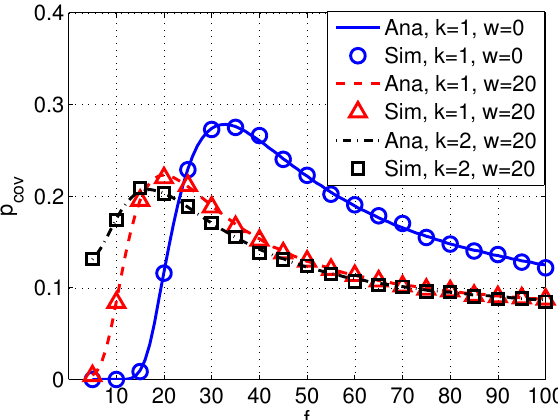
Figure 8. Coverage p cov versus frequency f with different spreading factor k and wind speed w . System parameters are set as R d = 12 km, P p = 110 dB, P s = 100 dB, λ p = 0.003, s = 1, δ s = 20 dB, and δ d = 20